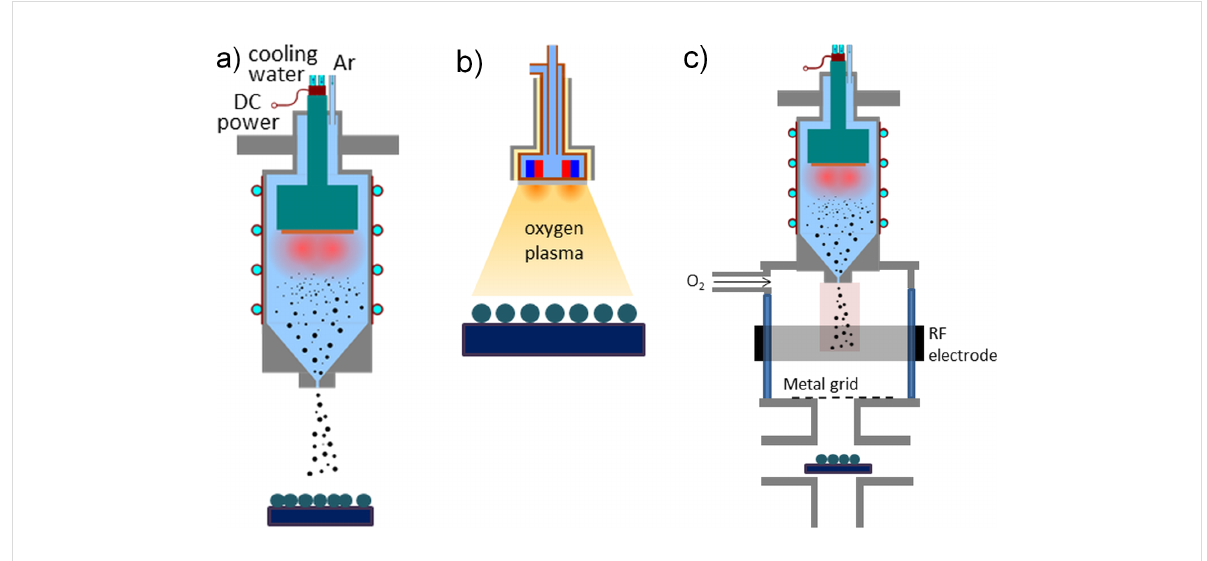
Figure 7: Schematic picture of (a) cluster deposition for samples of type 1, (b) treatment with oxygen plasma for samples of type 2 and (c) in-flight ox- idation of the clusters for samples of type